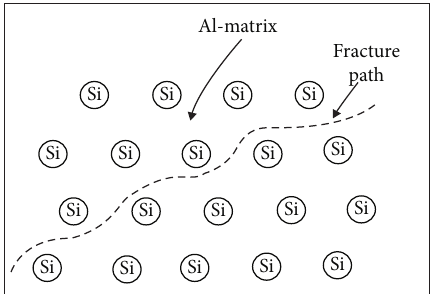
Figure 5: Fracture mechanism in Al-Si-Mg-based alloys [26].